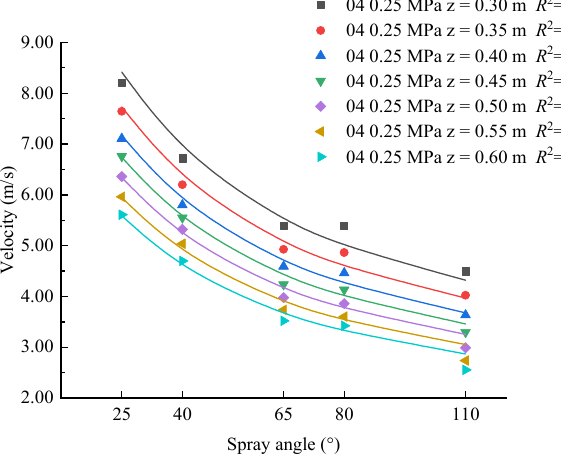
Figure 11. Fitting curves of droplet velocity vs. spray angle. As can be seen in Figure 12, the droplet velocity along the Z-axis increased with the increase in the equivalent orifice diameter at a constant spray angle of 65°. The fitting function between the equivalent orifice diameter and droplet velocity is represented as follows: